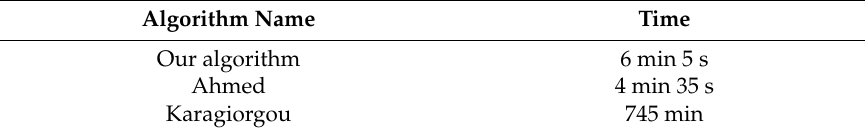
Figure 19. Cumulative Average Vertical distance. Table 1. Execution